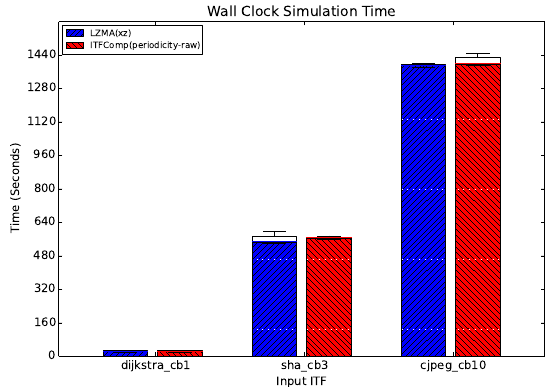
Figure 6: The wall clock simulation time of three com- pressed ITFs using LZMA(xz) and ITFComp. The bar plots represent the average, while the boxes represent the distri-